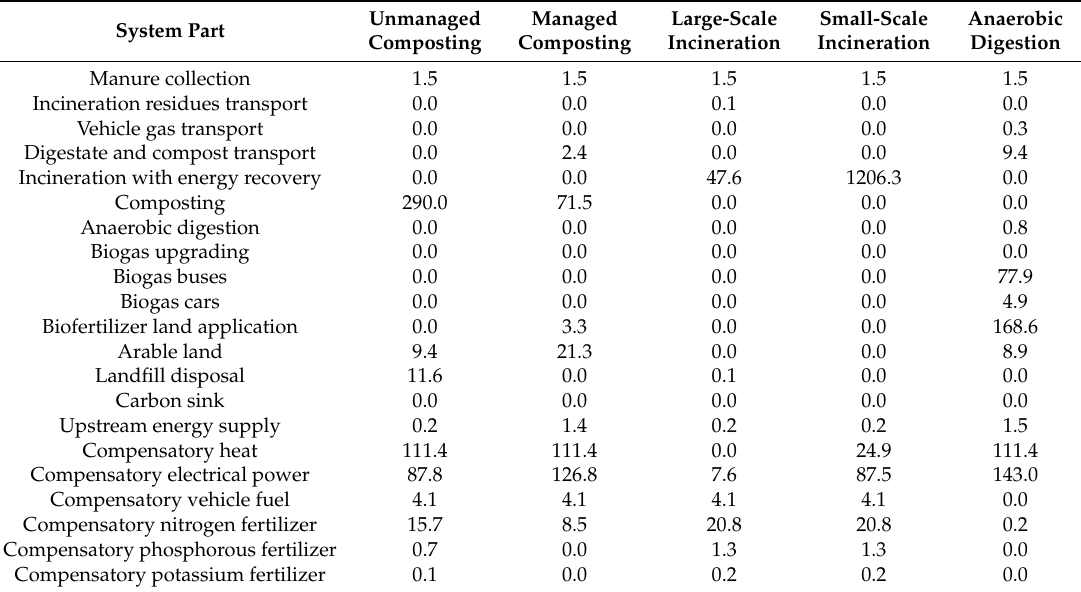
Table B4. Eutrophication Potential Air (kg PO 43 −